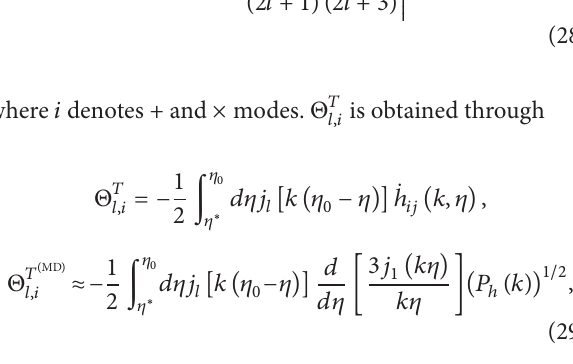
Figure 4: Time-averaged values of 𝐷(𝑘) 2 = 2⟨(𝑘𝜂) 2 |ℎ 𝑖𝑗 (𝑘𝜂)| 2 ⟩ as function of 𝑘[ Mpc −1 ] for the RMD scenario in case of including the collision term. Results are for 𝜏 = 0.01 and 10 and for the collisionless according to the legend, with 𝜏 in units of 𝜂 0 and 𝑘 in units of 1/𝜂 0 with red and black lines in correspondence with those from Figure